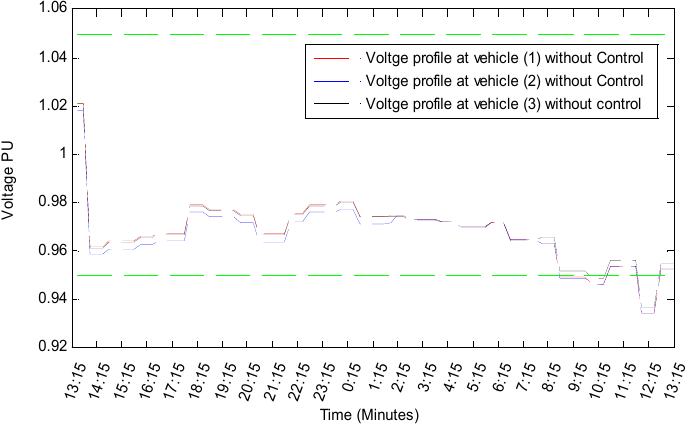
Figure 14. Voltage per unit of three different vehicles without charging control.